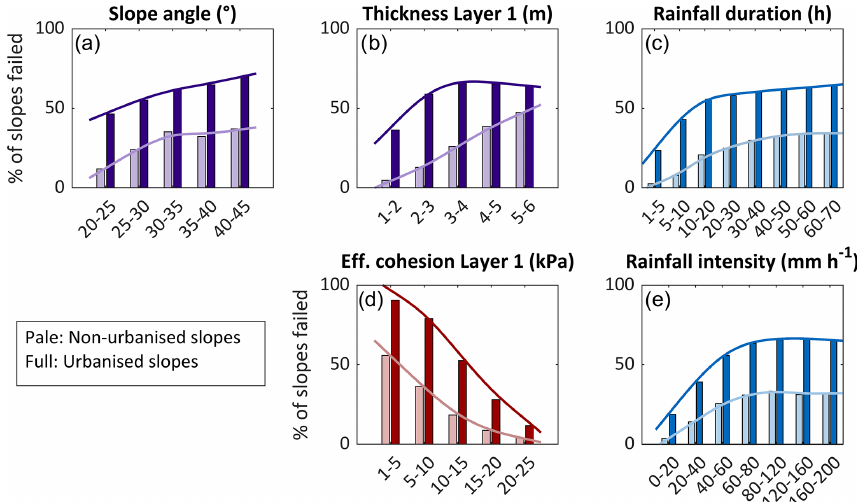
Figure 7. Percentage of slope failures for urbanised and non-urbanised slopes for different categories of input factors. Throughout, urbanised slopes show higher failure rates than non-urbanised slopes. In (a–c) the distribution of failure rates for urbanised slopes is more uniform for variations in input factors than the non-urbanised case, while in (d, e) it is more pronounced. Panels (a–c) represent the input factors whose sensitivity indices are smaller when urbanisation is introduced in Fig. 6, while (d, e) show the input factors whose sensitivity gets larger when urbanisation is introduced in Fig. 6.